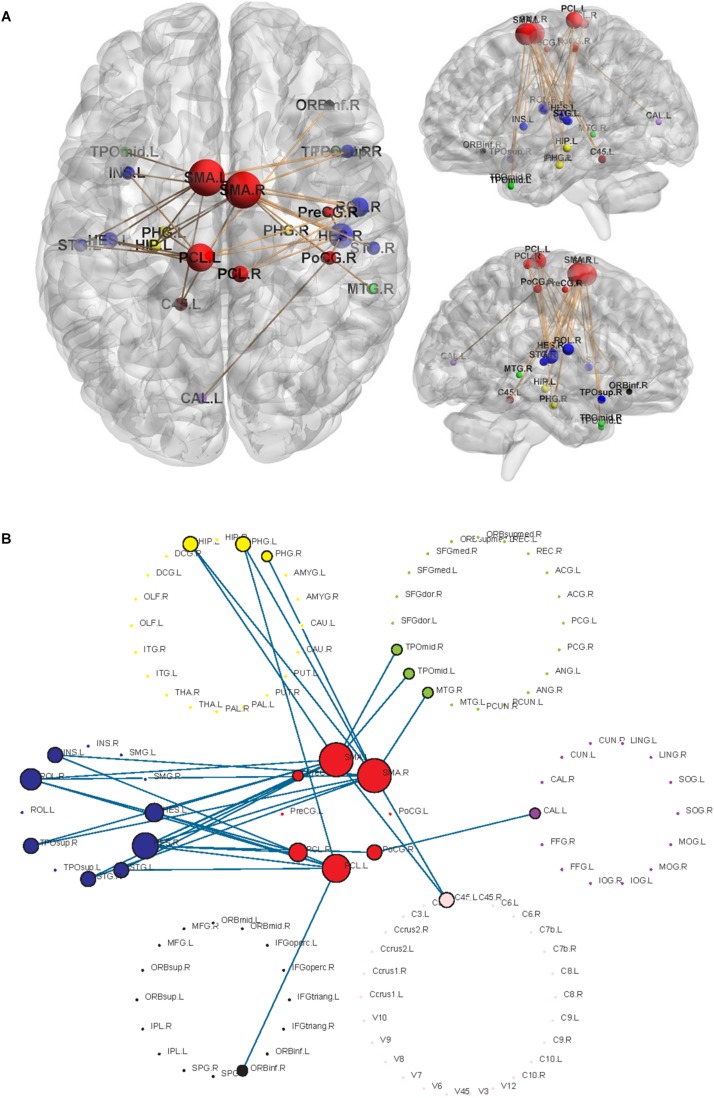
Significant networks characterizing T2D using NBS analysis. The radius of the nodes is proportional to the number of connectivities related to the nodes. Different colors represent different networks, red = sensory-motor network; blue = auditory network; yellow = subcortical network; black = attention network; green = default mode network; purple = visual network; pink = cerebellum. (A) The changed functional connectivities in T2D patients and the locations of the nodes involved in the brain. (B) Highlighted structures of 7 RSNs and changed connectivities.